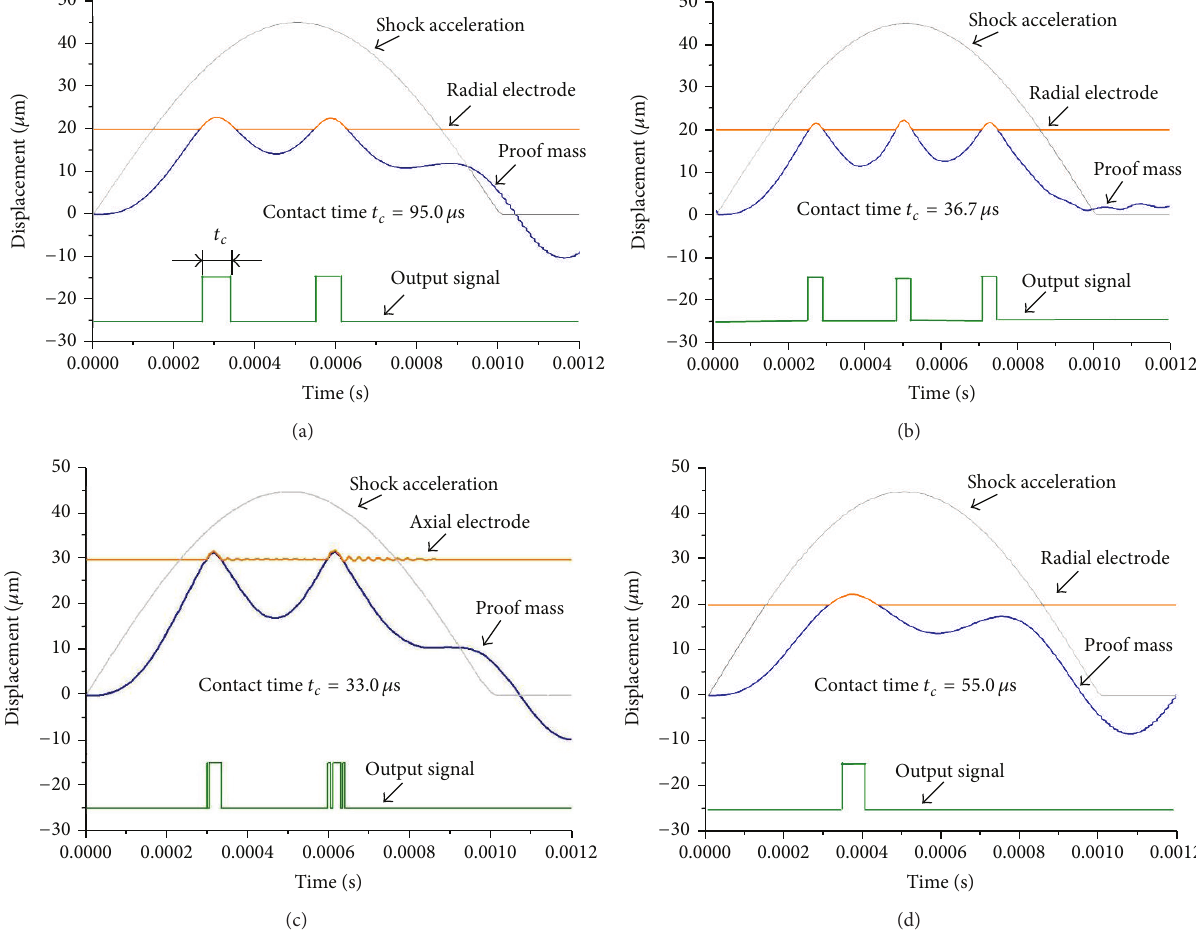
Figure 8: Dynamic simulation results of the switch in the direction of (a) 𝑋 -axis direction, (b) 45 ∘ with the 𝑋 -axis direction in the XOY plane, (c) 𝑍 -axis direction, and (d) 45 ∘ with the 𝑍 -axis direction in the XOZ